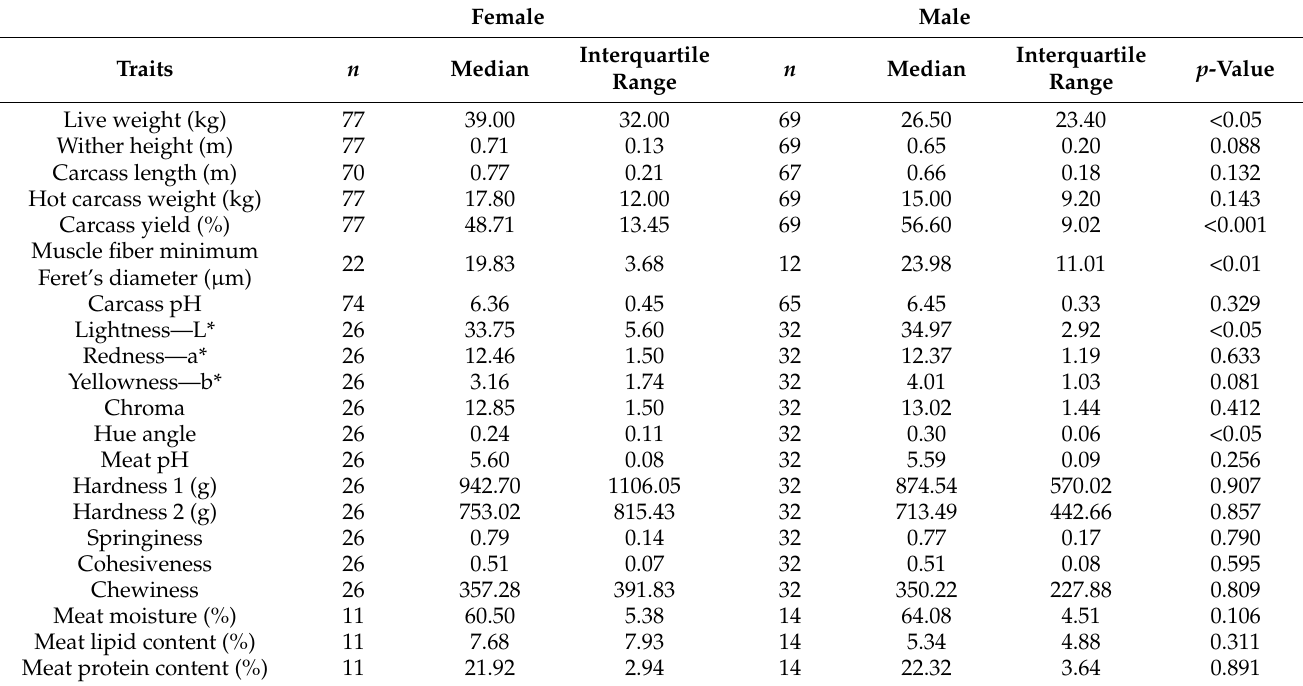
Table 3. Results of non-parametric Mann–Whitney U tests performed to compare between sexes of fat-tailed sheep (rejection of null hypothesis when p < 0.05: Differences between medians of groups are statistically significant, hence groups come from different populations).